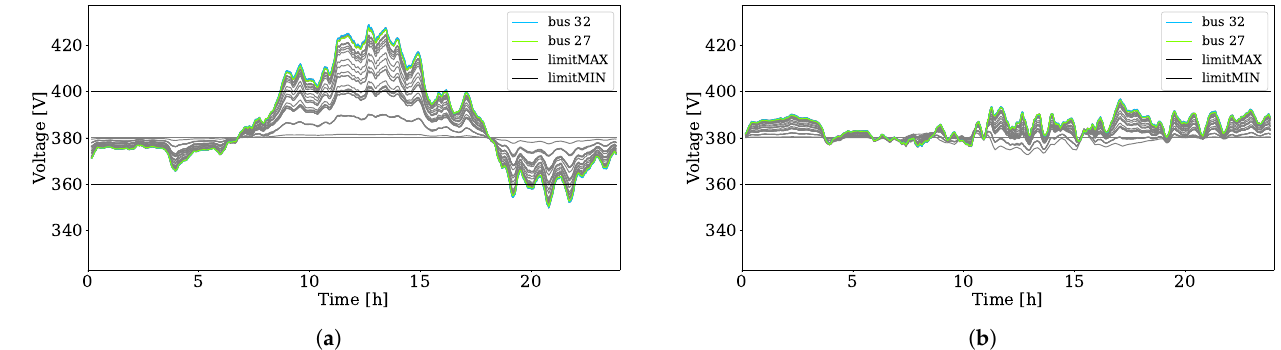
Figure 9. Results of the hierarchical control #1. ( a ) Voltage with no control applied; ( b ) after the MPC and online